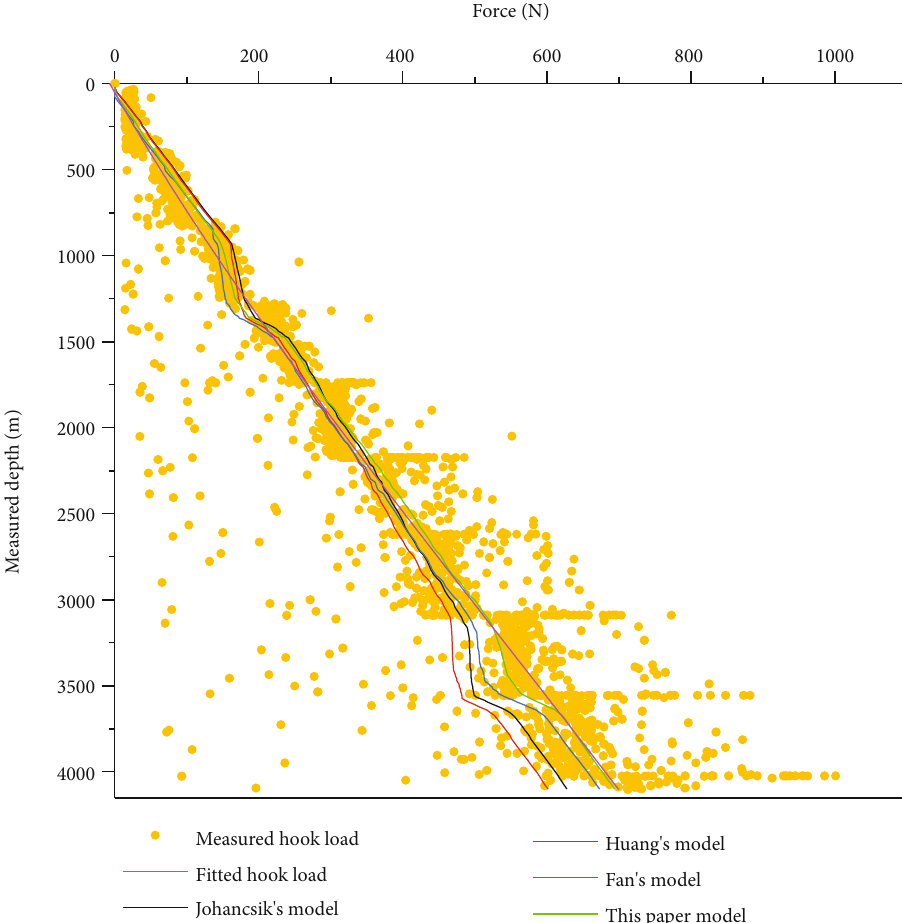
Figure 10: Axial load on the casing string using di ff erent